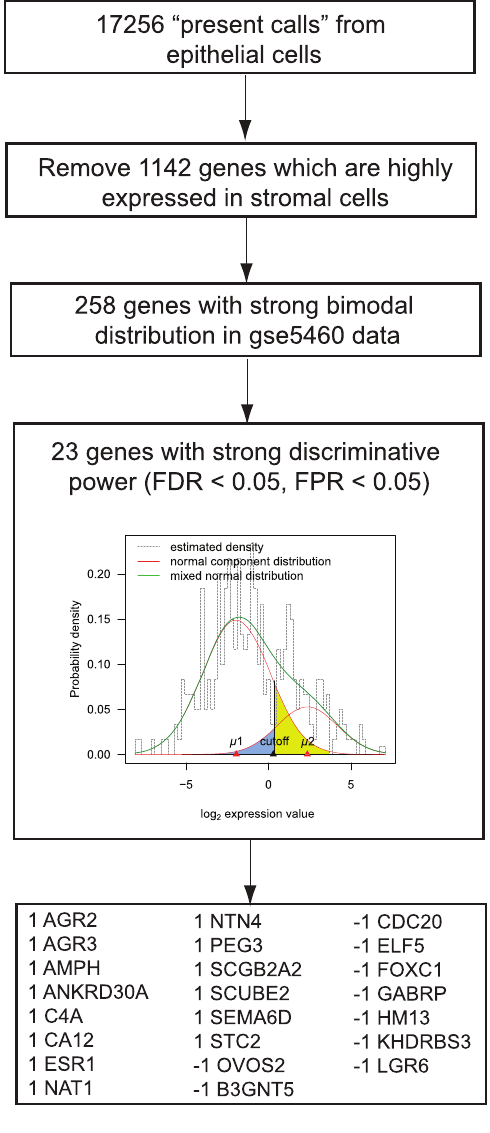
Figure 1. Schematic of deriving the 23-gene ER signature from epithelial specifically expressed